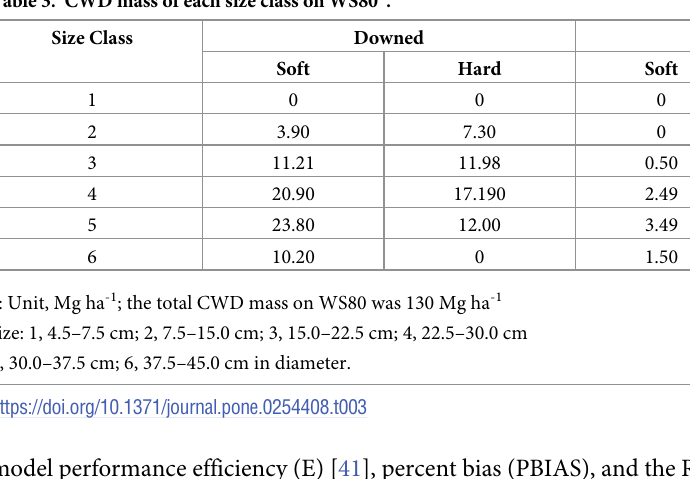
where O and P are the observed values and the predicted values obtained from the modelling, i i respectively; � O is the observed mean. The evaluation criteria are: if E < 0.0, the model is not applicable; 0.0 � E < 0.25, the model performs poorly; 0.25 � E < 0.5, the model performance is fair; 0.5 � E < 0.75, model performance is good; and if E � 0.75, the model performs excellently. The evaluation variables, PBIAS (criteria: between -25.0% and 25.0%) and RRS (criteria: 0.0–0.7), are calculated, respectively, as